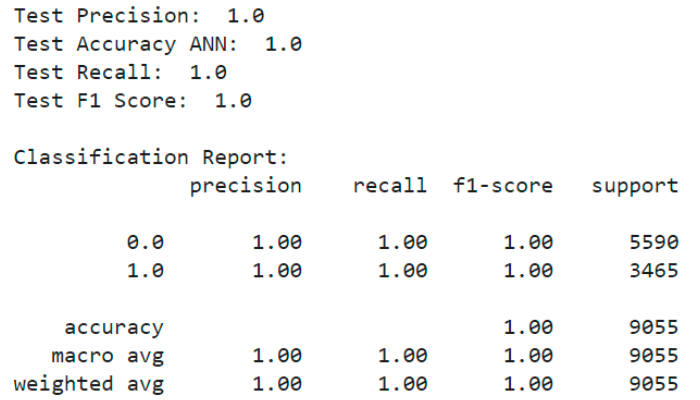
Figure 6. ANN-based Classification Report.